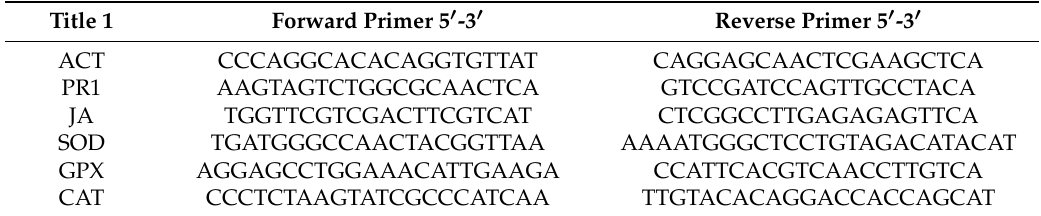
Table 1. Primers sequence of analyzed